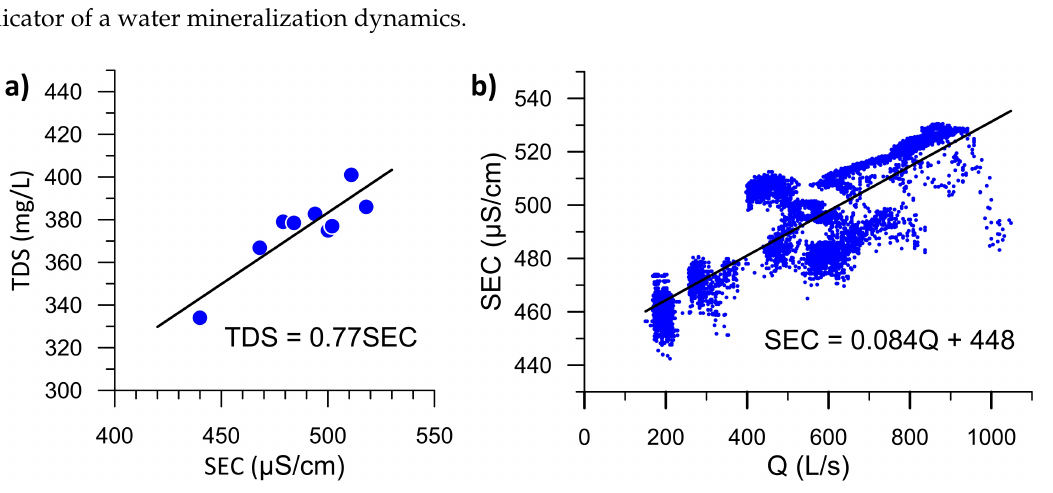
Figure 6. Correlation of specific electrical conductivity (SEC) measurements of the main spring water with ( a ) total dissolved solids (TDS) contents in water samples (based on analysis of major ions); and ( b ) simultaneous discharges of the main